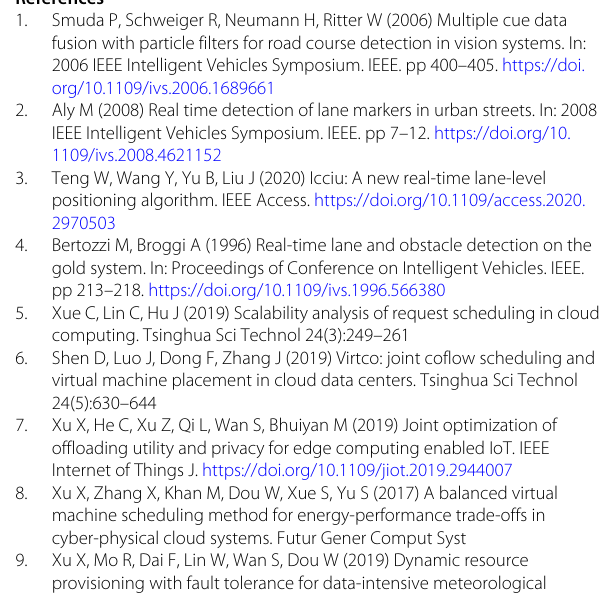
such as shadows and obstacles. In order to improve the efficiency of central computing, a two-branch training network and a customized training network based on semantic segmentation are proposed, and the combina- tion of vehicle edge calculation and actual engineering can improve the effect of lane line detection